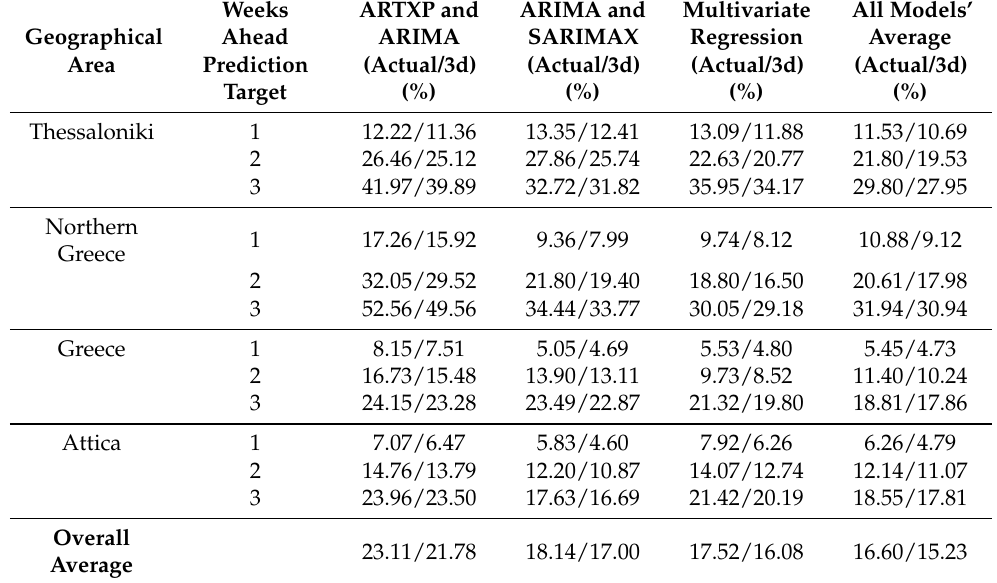
Table 2. MAPE of Predicted vs. Actual ICUs.